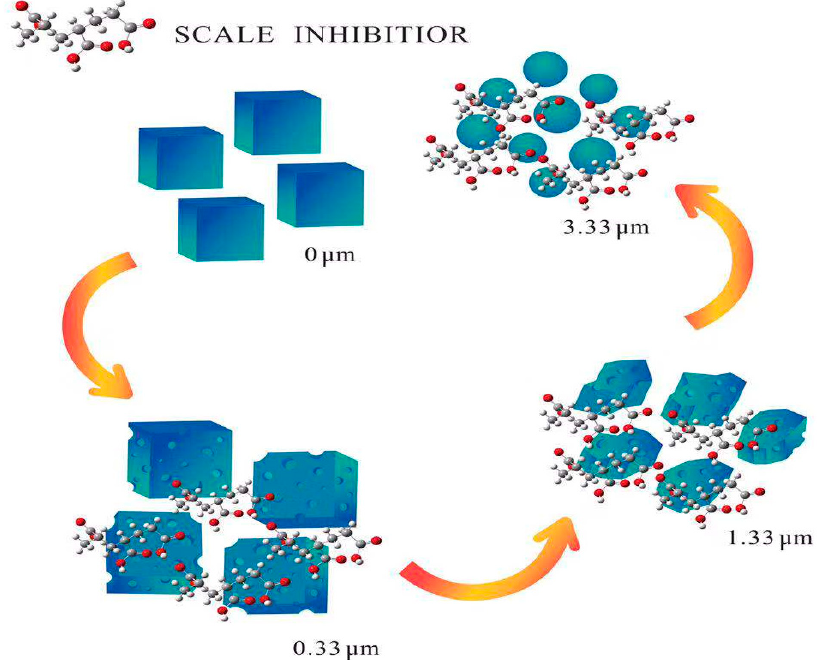
Figure 9. Schematic illustration of the mechanism.